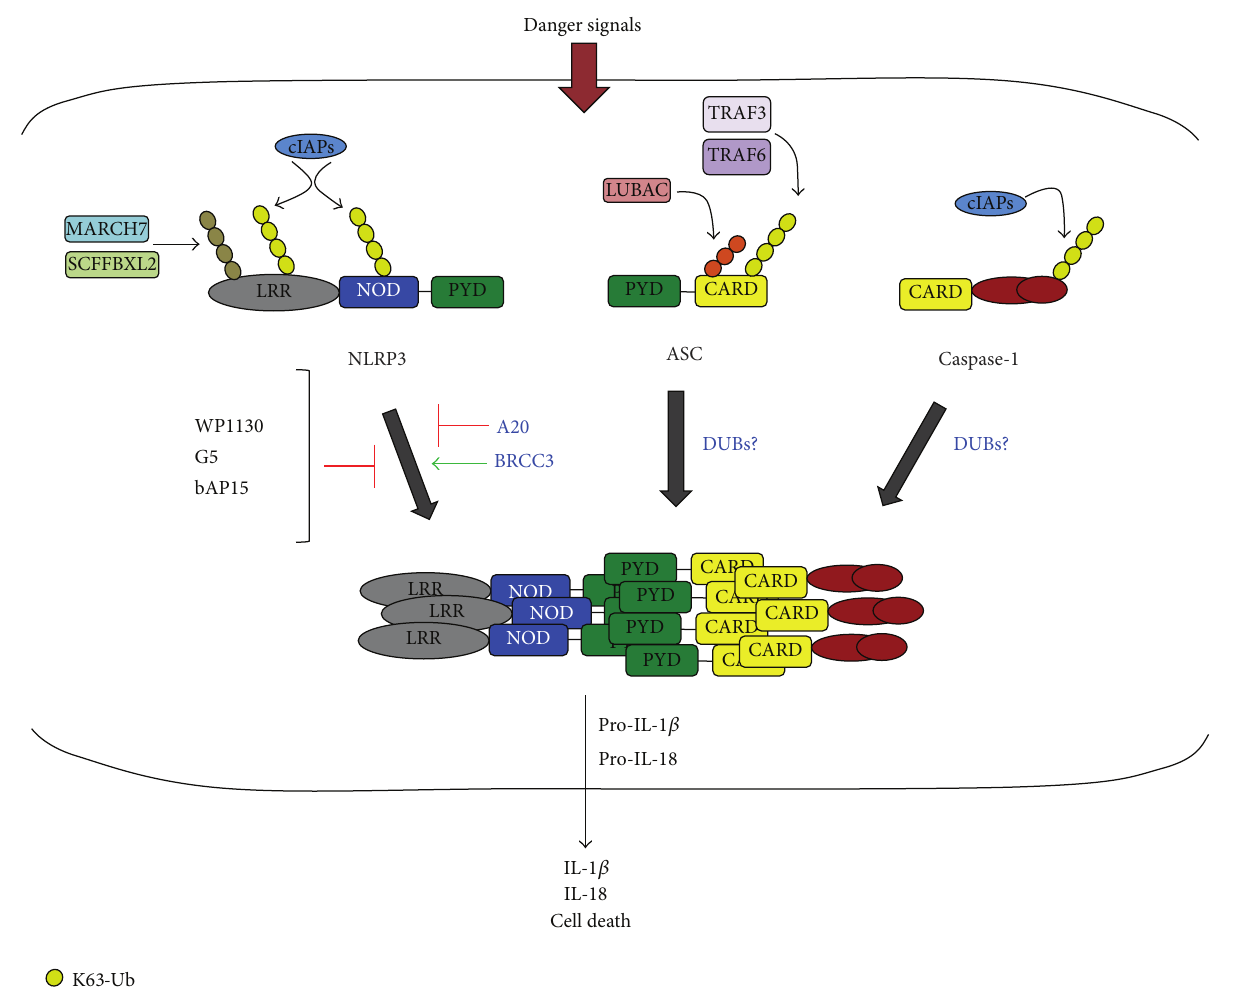
Figure 3: Regulation of the NLRP3 inflammasome activation by the ubiquitin-proteasome system. Assembly of the NLRP3 inflammasome complexoccursinresponsetoawidevarietyofdangersignalsincludingATP,bacterialtoxins,orparticulatemattersuchasmonosodiumurate crystals.TheubiquitinligasesMARCH7andSCFBXL2addK48-linkedpoly-UbchainstoNLRP3asameantocontrolitslevelsbyproteasomal degradation. cIAPs on the contrary add K63 poly-Ub chains to NLRP3 and caspase-1, contributing to the assembly of the complex. A20 also acts as a negative regulator of this complex. However, BRCC3 can deubiquitinate NLRP3, allowing it to form the complex and acting as a positive regulator of this pathway. TRAF3, TRAF6, and LUBAC also ubiquitinate ASC by K63 or M1 poly-Ub chains and this contributes to complex assembly. How other DUBs contribute to the assembly of the NLRP3 complex still remains